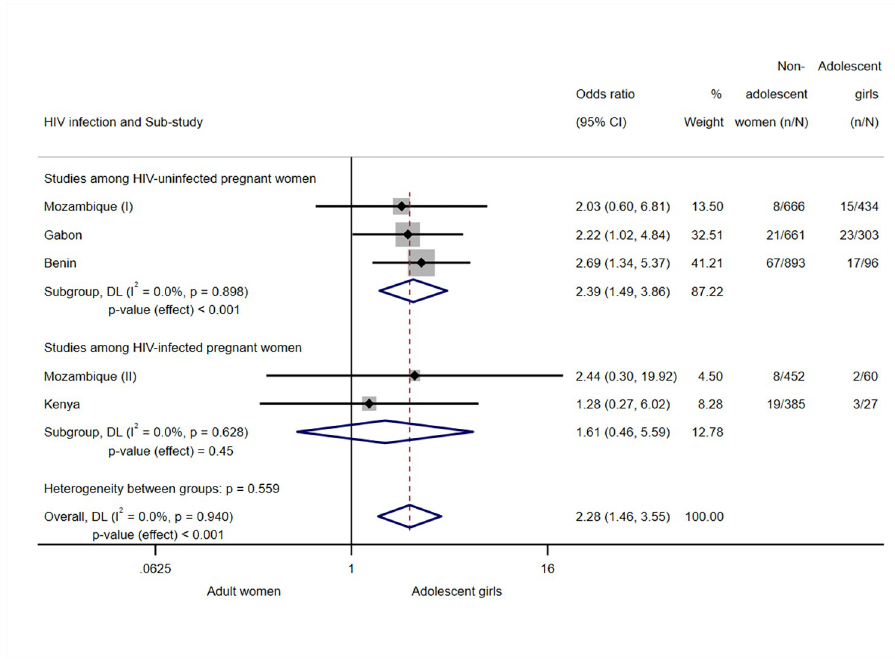
Fig 2. Analysis for peripheral parasitaemia at delivery. Notes: Analyses adjusted by trial arm, gravidity, literacy, gestational age at recruitment, MUAC, anaemia at recruitment, adherence to the treatment (IPTp), and season at recruitment. Weights and between-subgroup heterogeneity test are from random-effects model. Tanzania (I), HIV- uninfected participants, and Tanzania (II), HIV-infected participants, were excluded from the analysis since no cases of peripheral parasitaemia at delivery were found among study participants in the site. CI, confidence interval; DL, DerSimonian–Laird random effects model; MUAC, mid-upper arm circumference; OR, odds ratio.